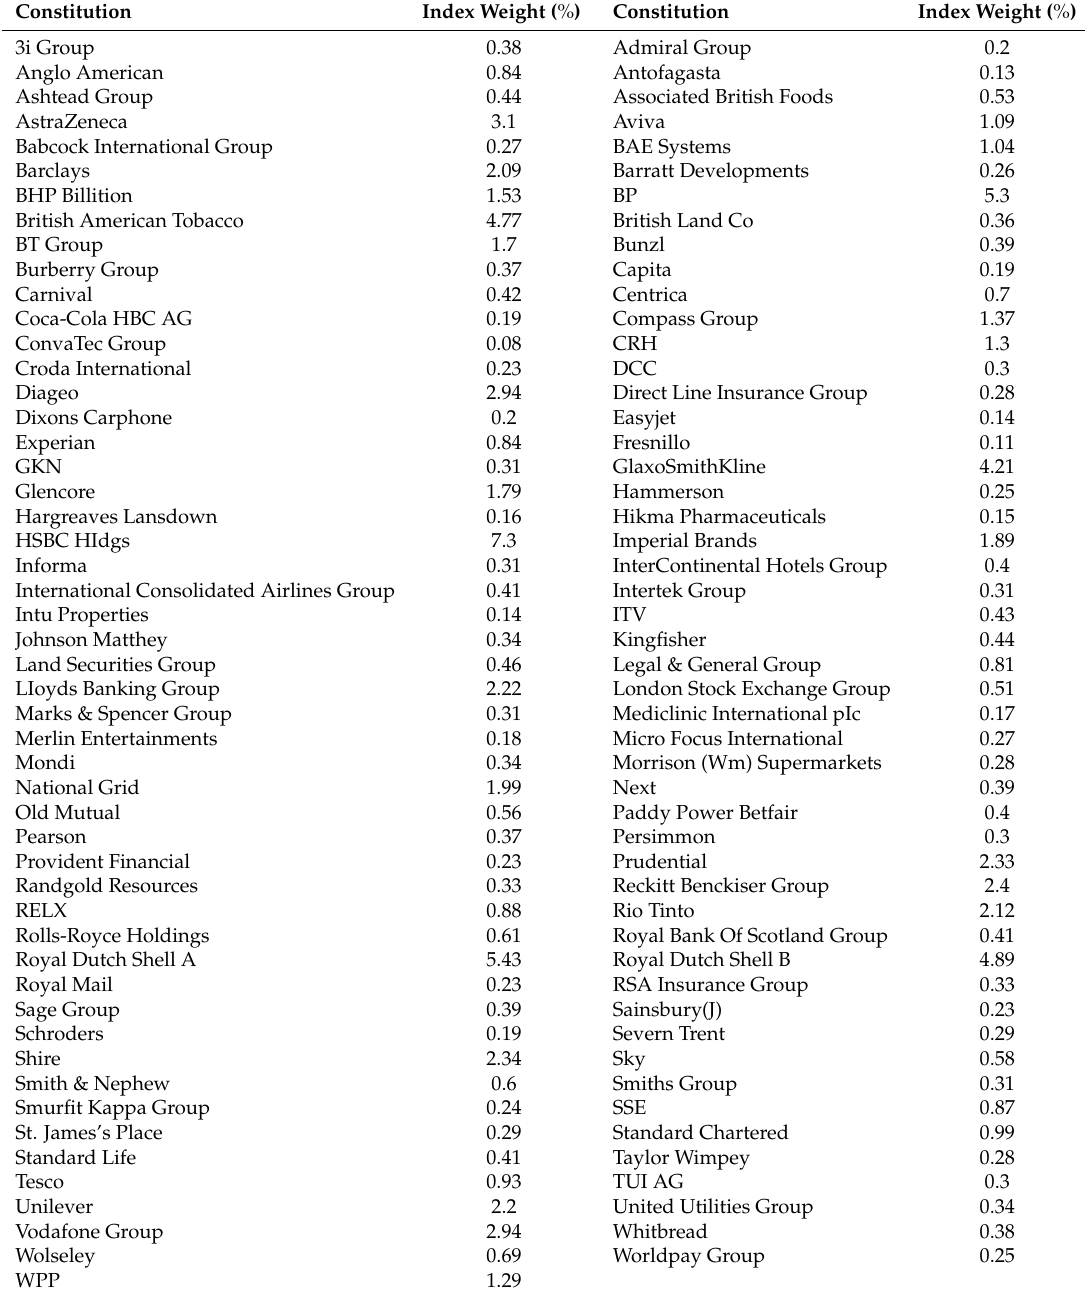
Table A1. The specific index weight data of FTSE100